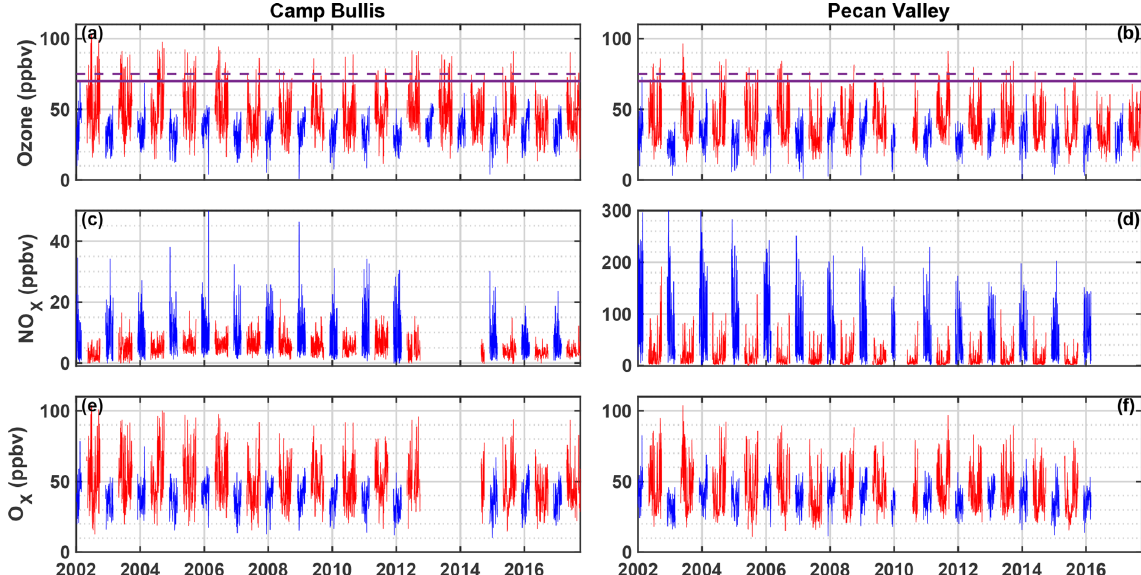
Figure 1. Time series of maximum daily average 8h (MDA8) O 3 , NO x , and O x at the Camp Bullis (a, c, e) and Pecan Valley (b, d, f) TCEQ sites for 2002–2017. Summer months (May–September) are shown in red, and winter months (December–February) are shown in blue. MDA8 is calculated by determining the maximum value of a species from running 8h averages throughout the day. The purple dashed and solid red lines represent the 2008 (75ppbv) and 2015 (70ppbv) O 3 standards, respectively. Data were downloaded from https: //www17.tceq.texas.gov/tamis/index.cfm?fuseaction=home.welcome (last access: 27 January